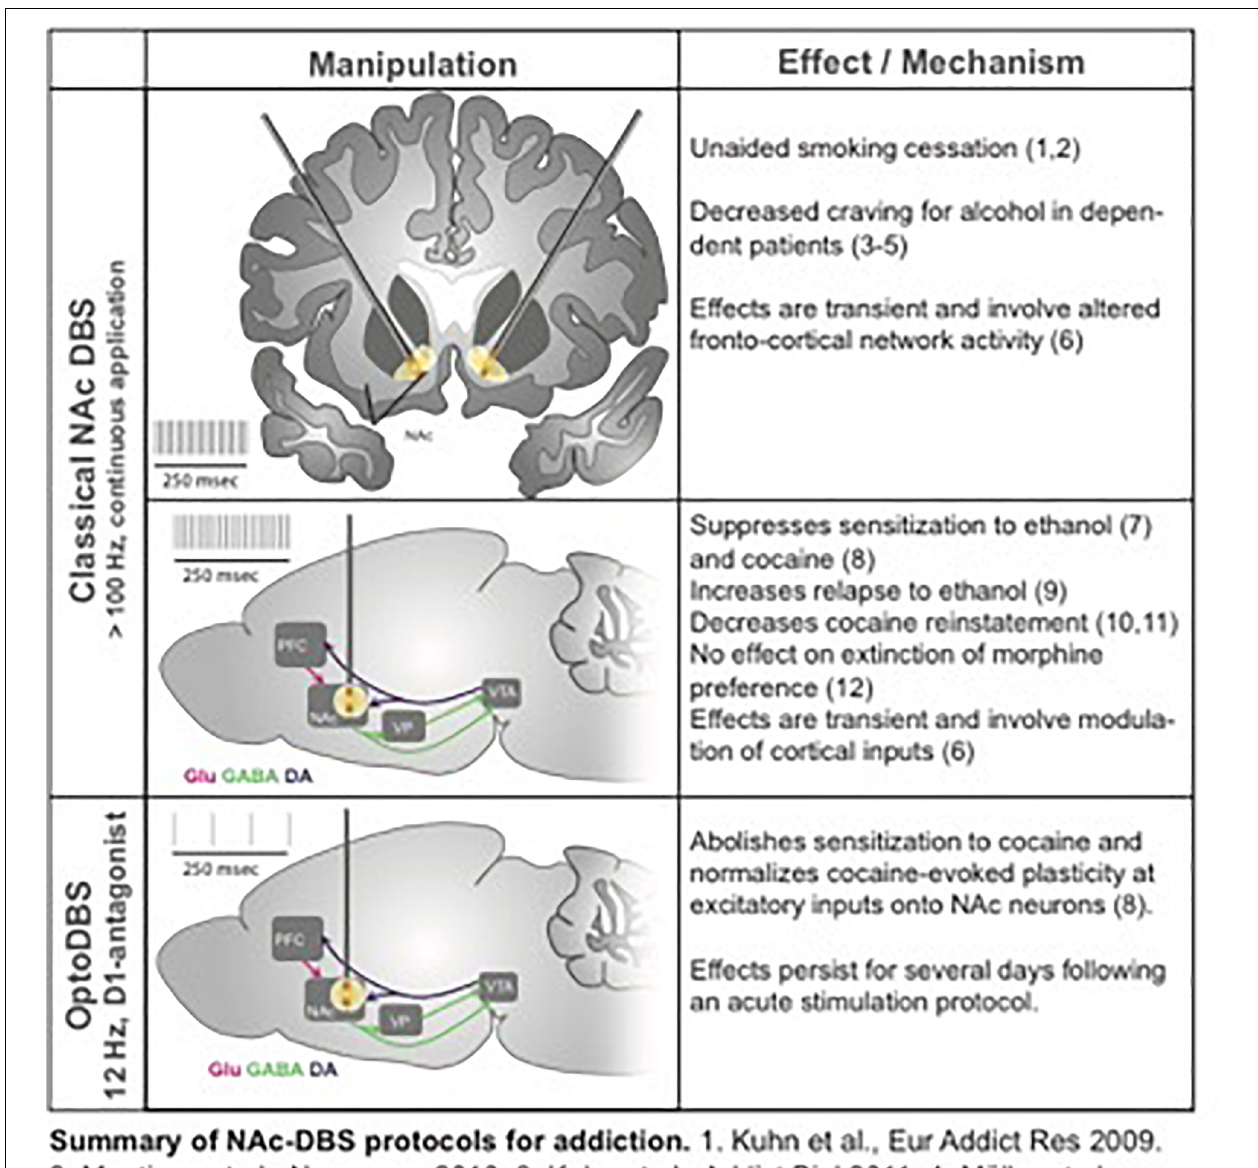
FIGURE 9 | Approaches to Addiction